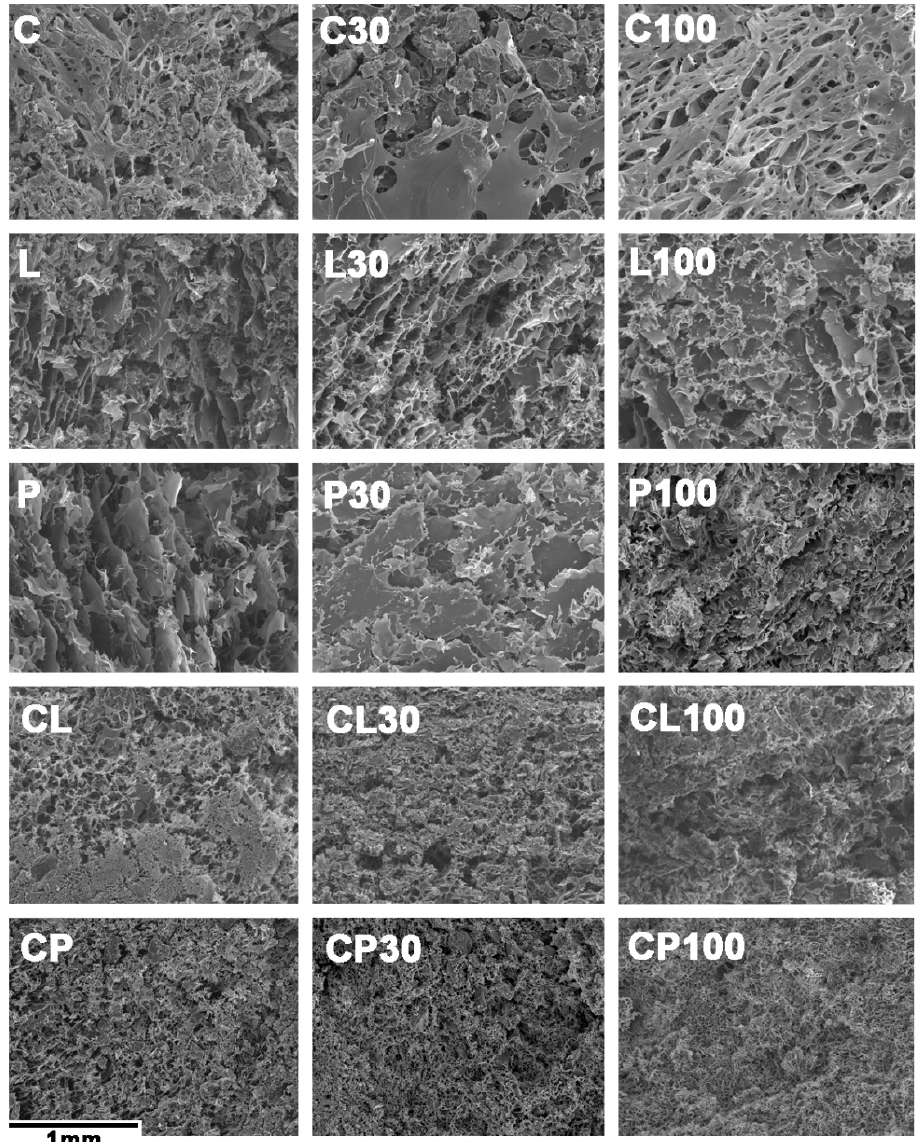
Figure 6. Images obtained through scanning electron microscopy (SEM) of the witnesses at 100 times magnification.